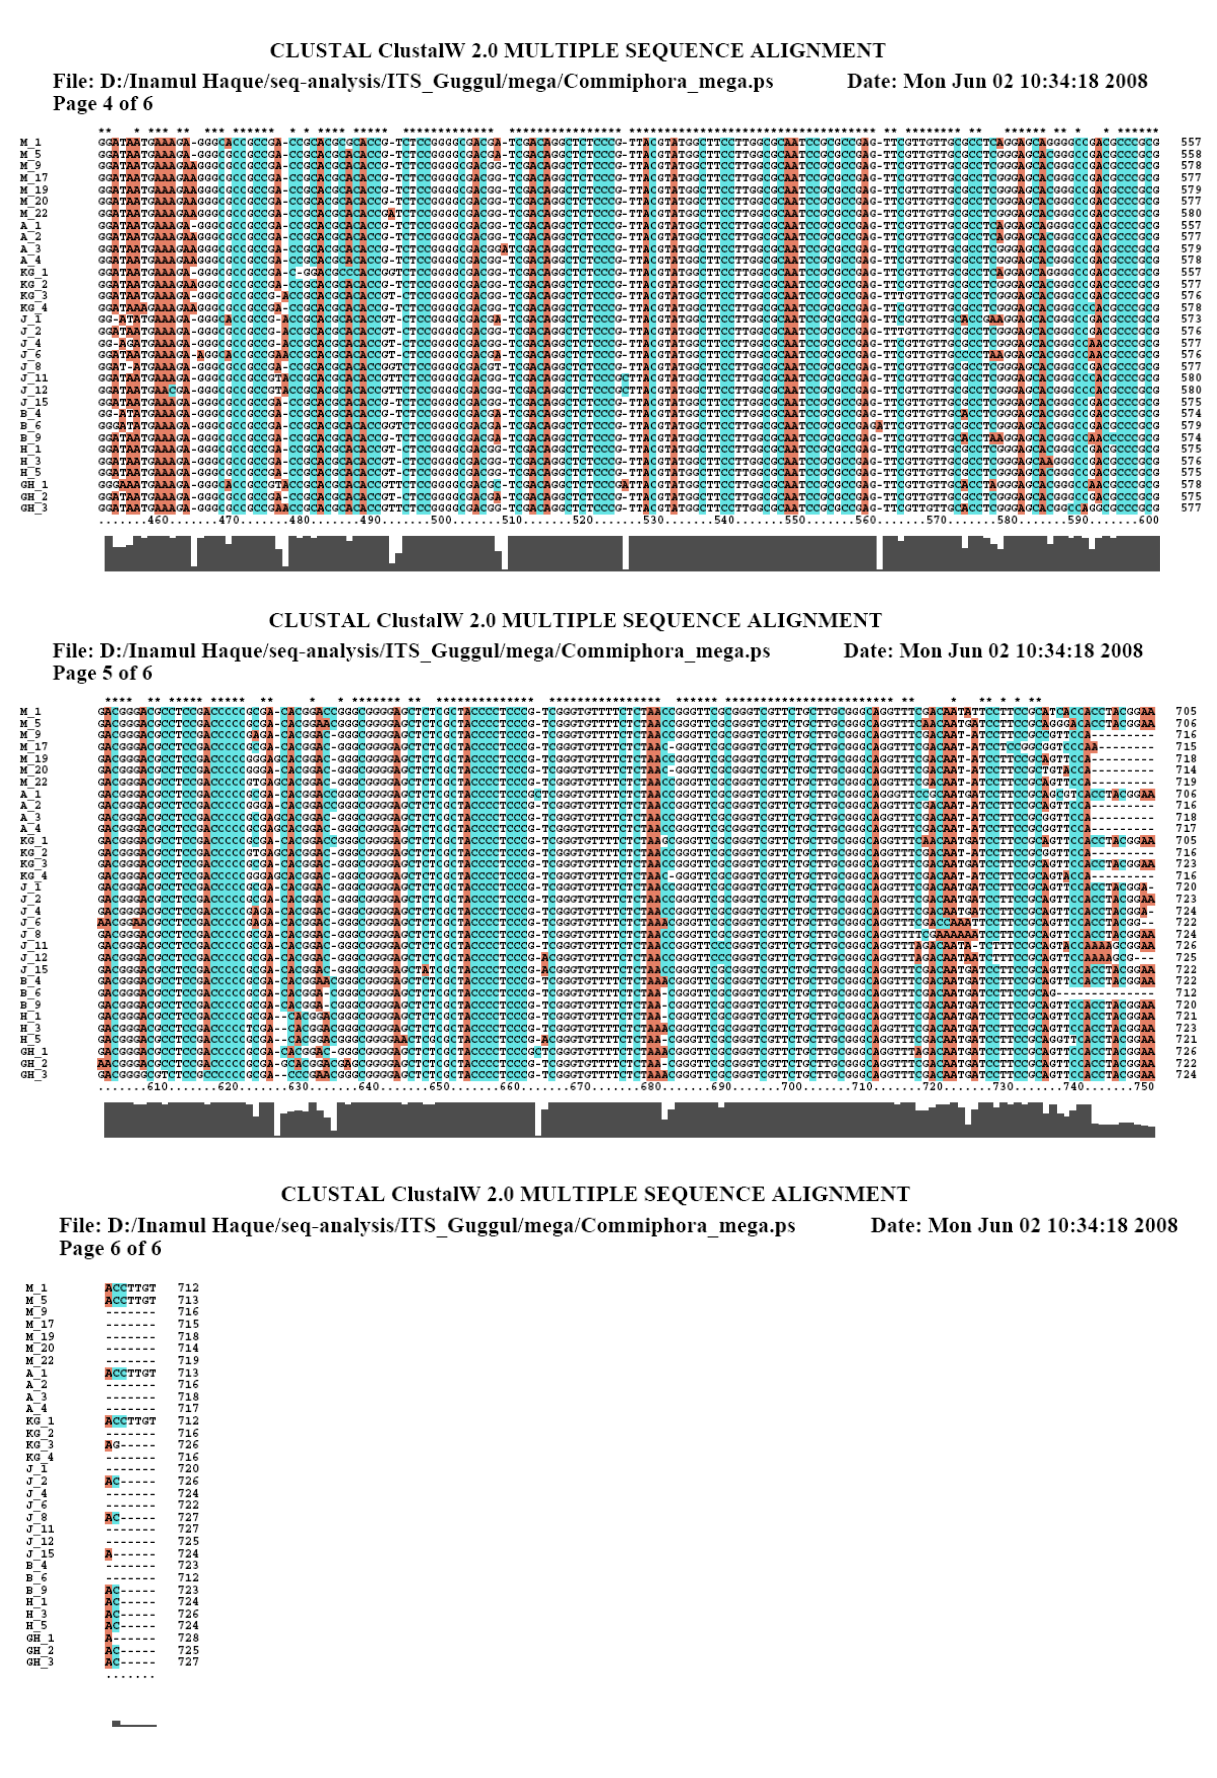
Supplementary Data 2. Cont